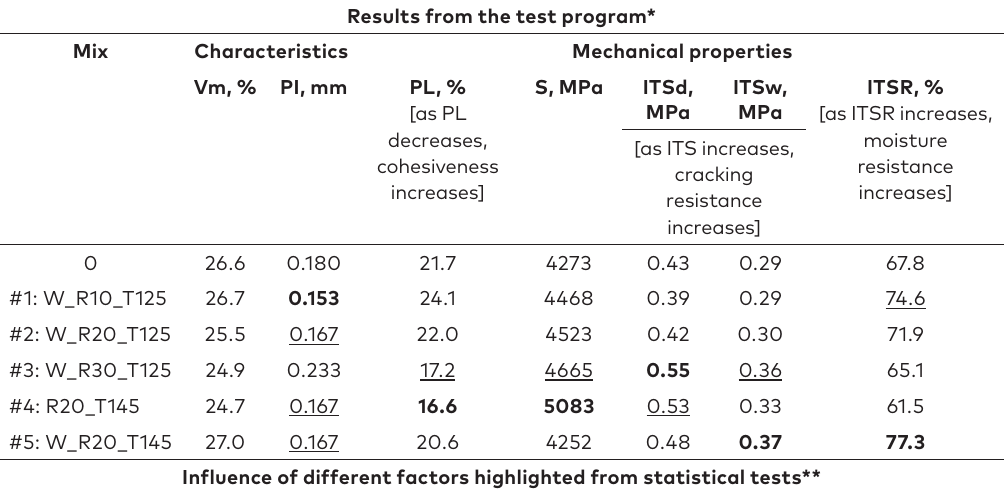
Table 5. Summary and comparison of results from the test